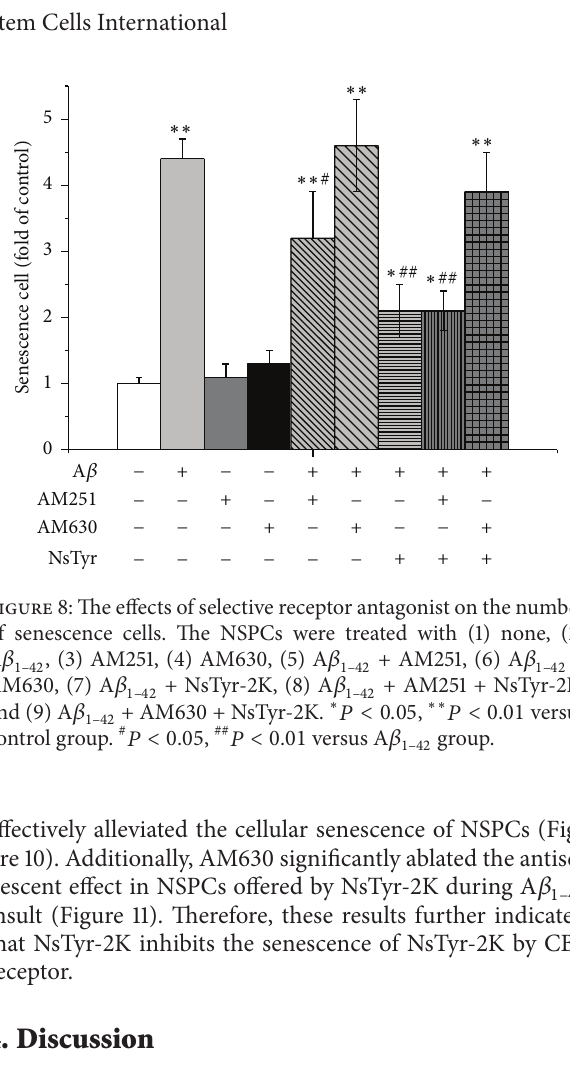
+ AM251, (6) A 𝛽 1 + – 42 – 42 + AM251 + NsTyr-2K, – 42 – 42